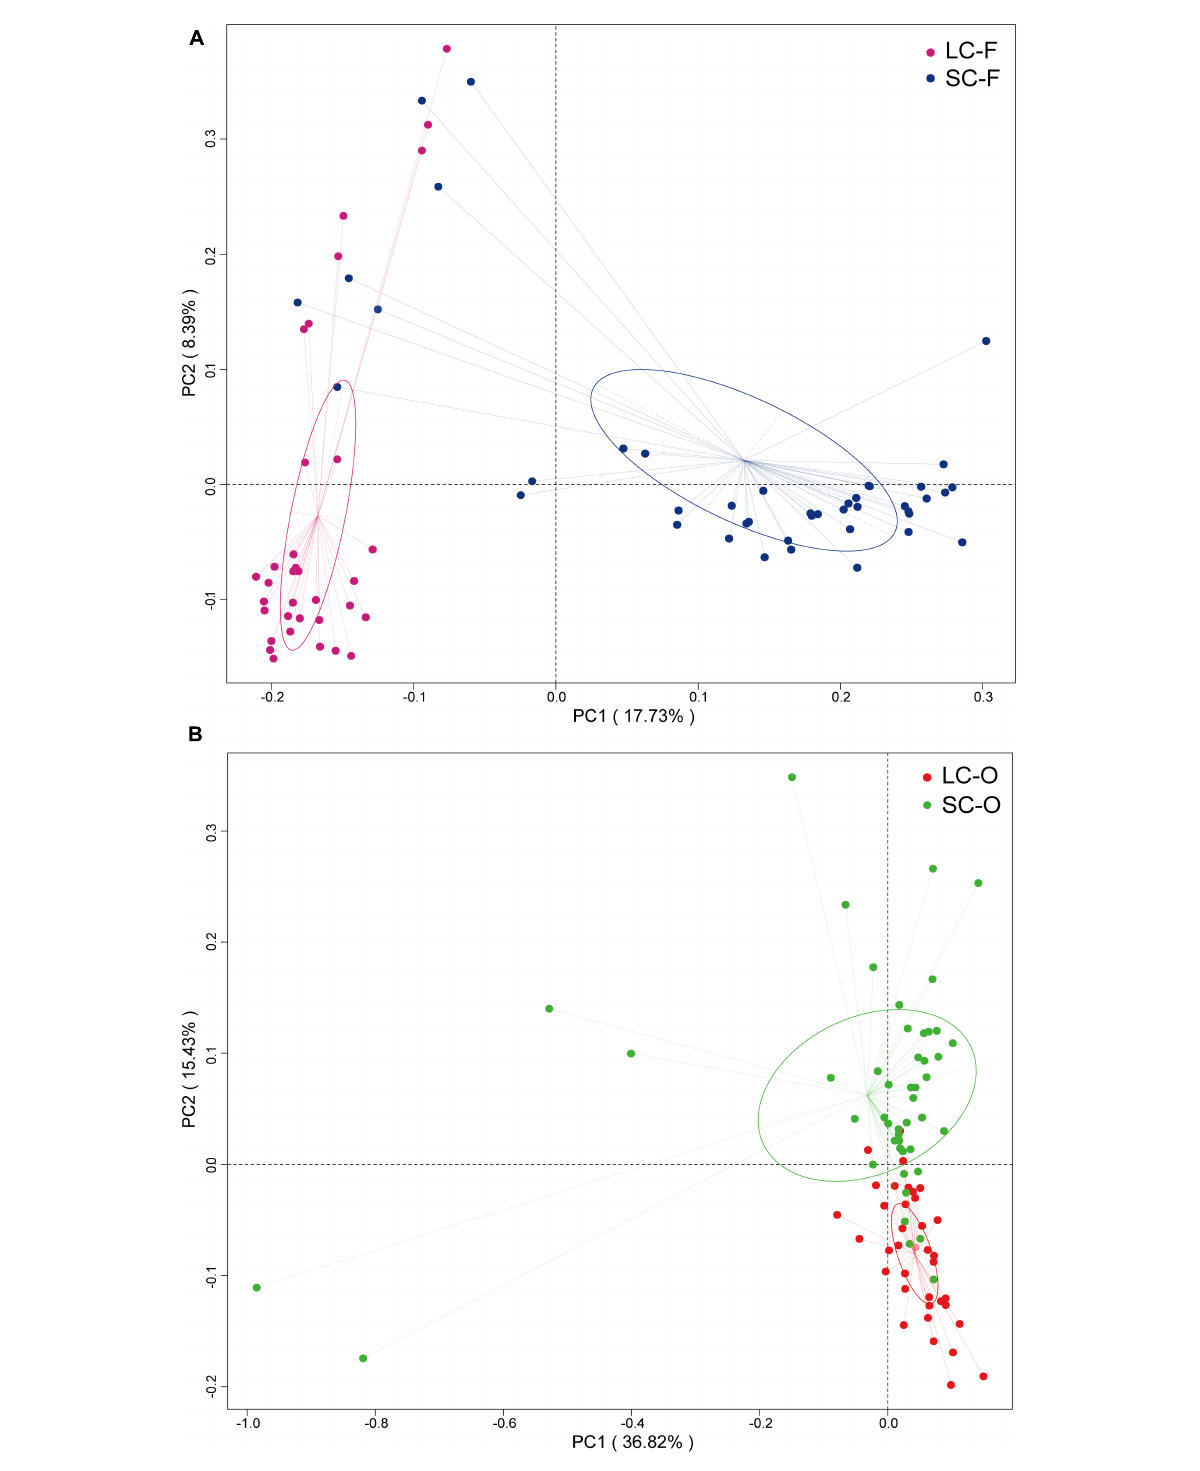
FIGURE3 Principal coordinate analysis (PCoA) analysis of gut microbiota based on binary Jaccard distances (A) and oral microbiota based on weighted UniFrac dissimilarities (B)